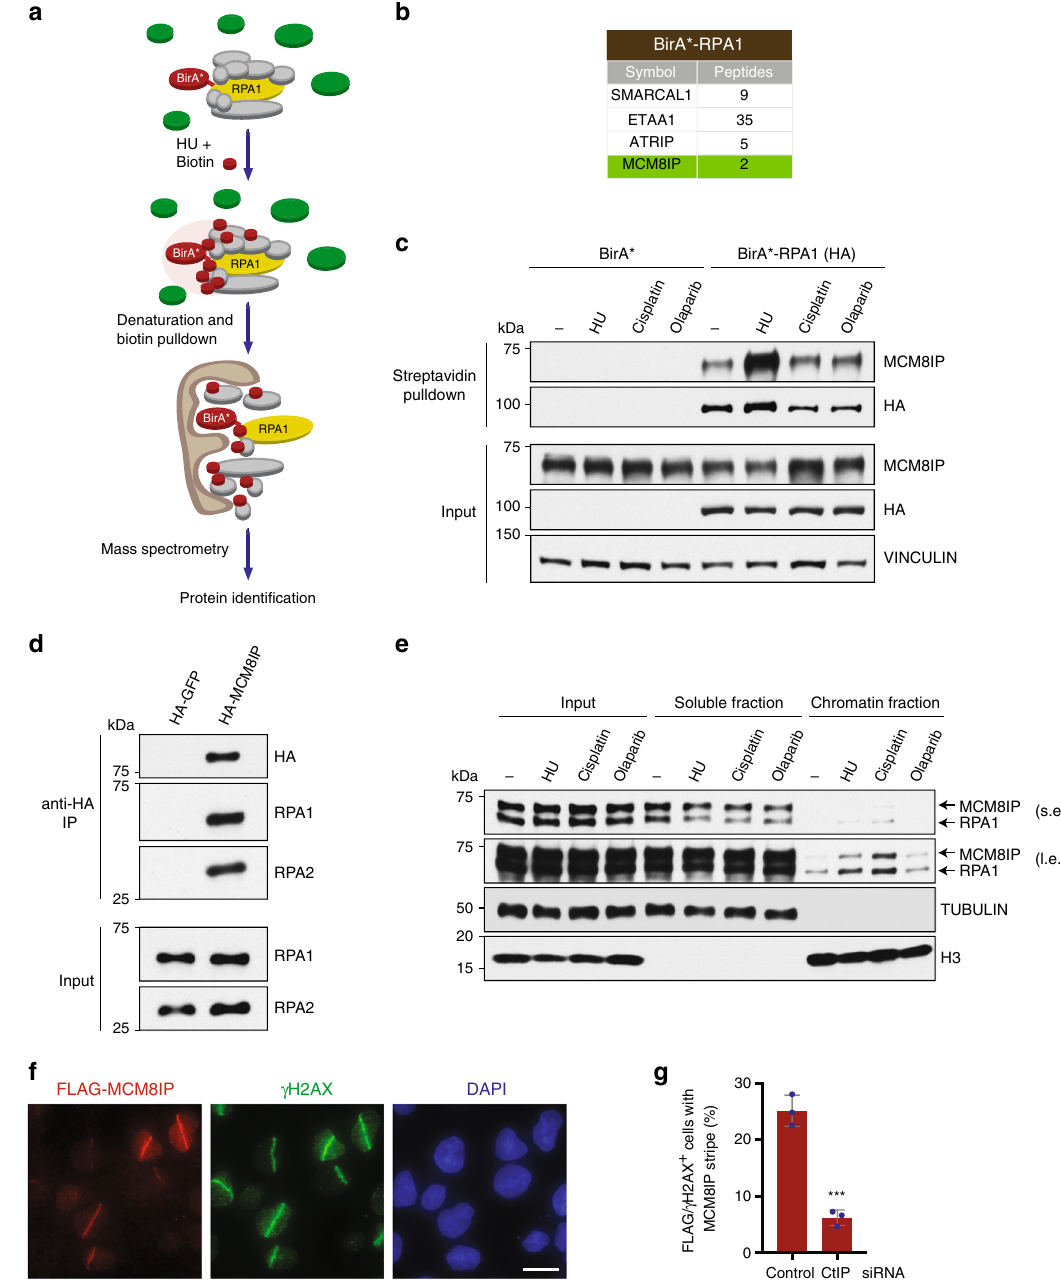
Fig. 1 Identi fi cation of MCM8IP by proximity-dependent biotin-identi fi cation (BioID) technology. a Schematic of the protocol used to identify RPA1 interactors by BioID. HEK293T T-REx cells expressing doxycycline-inducible BirA*- or BirA*-RPA1 were treated with HU in the presence of exogenous biotin. Biotinylated proteins were captured in denaturing conditions from cell lysates by streptavidin pulldown and subjected to mass spectrometry for protein identi fi cation. b List of selected proteins identi fi ed by mass spectrometry that were enriched in streptavidin pulldowns conducted from BirA*-RPA1- expressing HEK293T T-REx cells relative to pulldowns performed from control BirA*-expressing cells. See also Supplementary Data 1. c Detection by western blot of MCM8IP in streptavidin pulldowns from HEK293T T-REx cells expressing BirA* or BirA*-RPA1. Cells were treated with HU (1 mM),